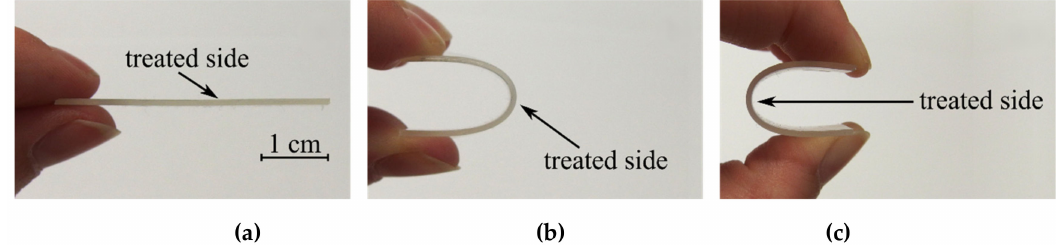
Figure 2. Illustration of the qualitative bending test: pictures ( a ) to ( c ) shows the bending